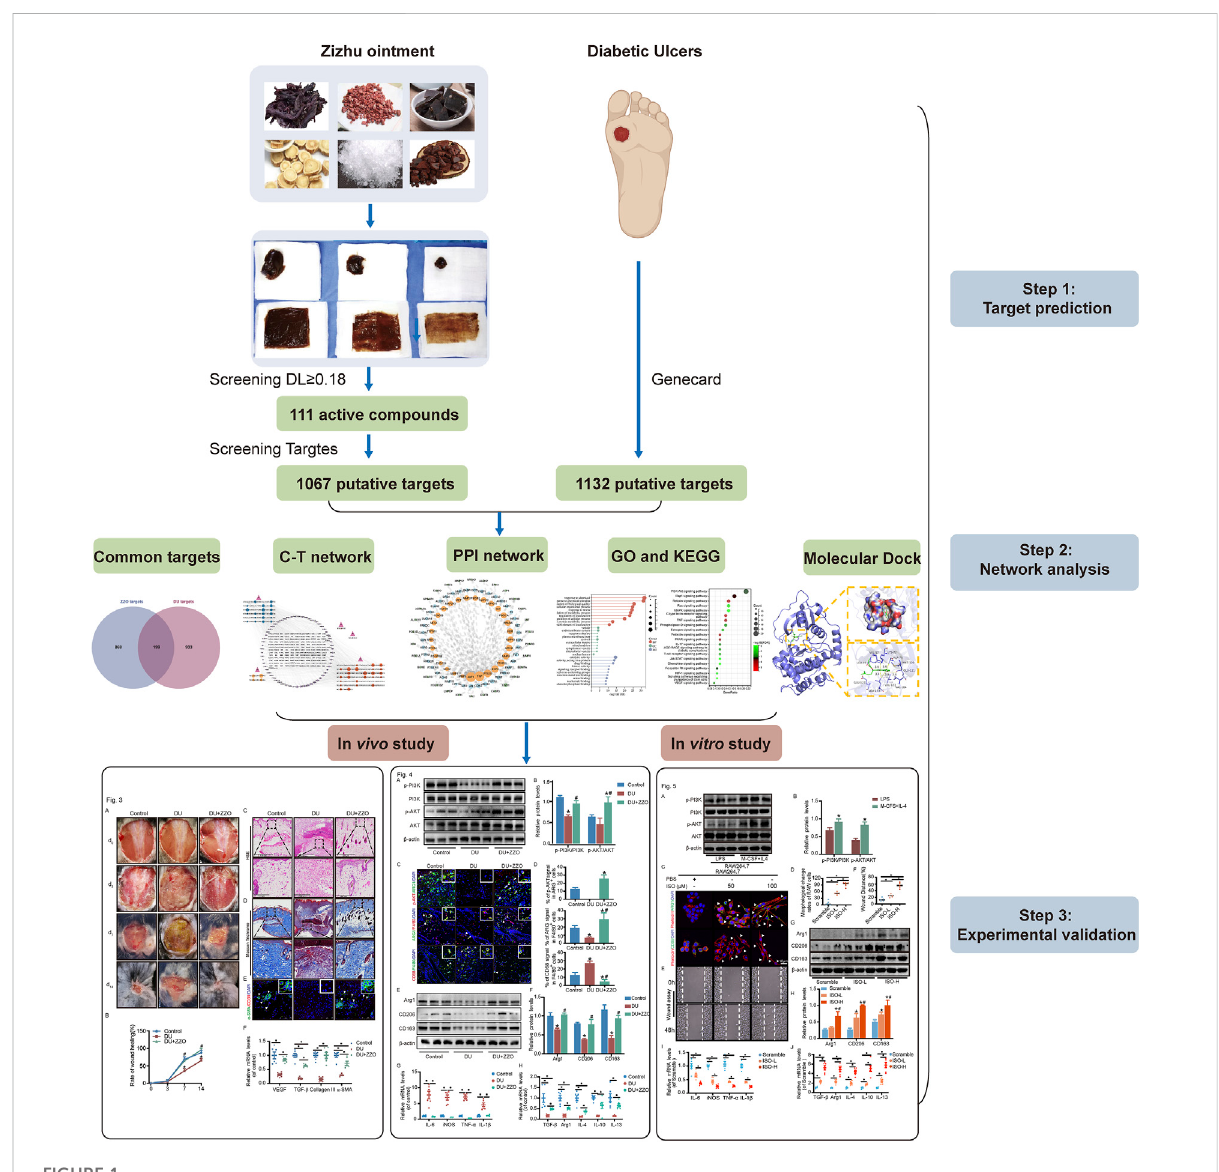
FIGURE 1 Graphical summary of this